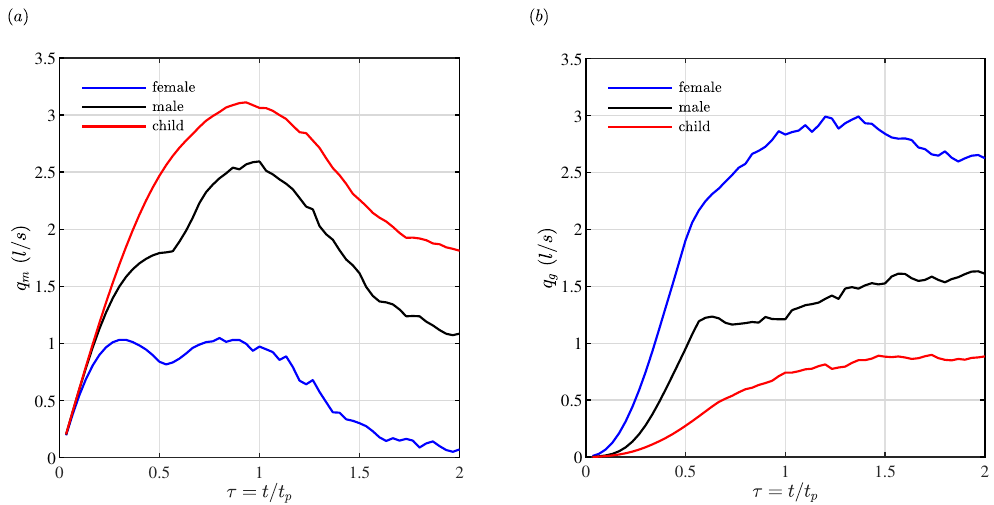
Figure 4. Time evolution of ( a ) through-mask flow and ( b ) gap leakage flow during a coughing episode for mask with porosity c k = 100 Pa ·